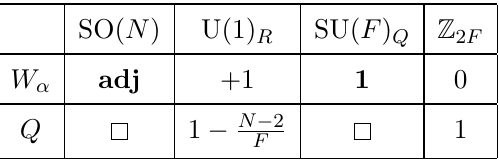
Table 7 . Quantum numbers of fields in the electric SO( N ) SQCD.